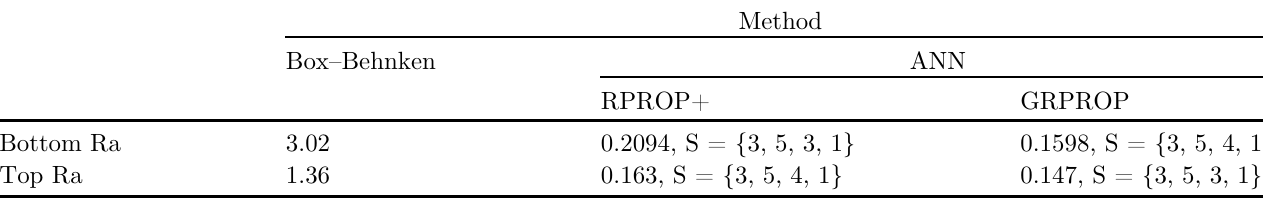
Table 12. MSE comparison for different